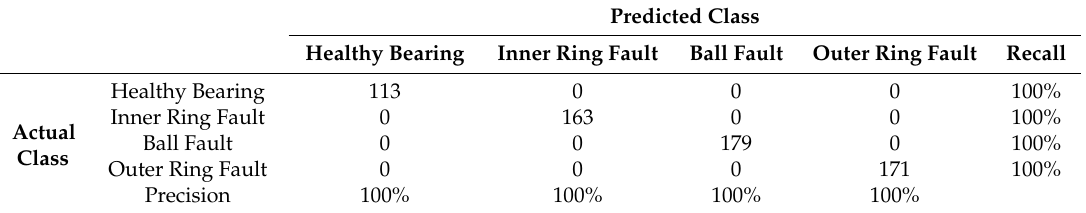
Table 9. Classification rate for Cooperative GA-neural network based Fault Diagnosis (Training data).